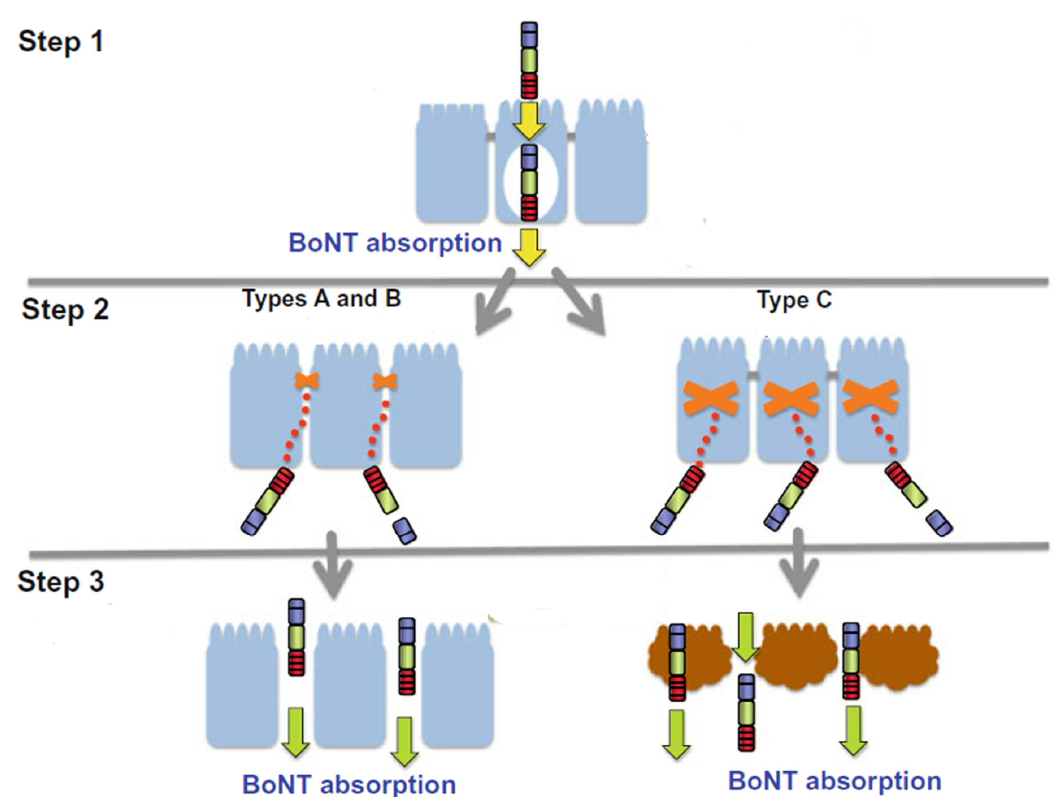
Figure 3. The proposed model for BoNT across the intestinal epithelial barrier (modified from Fujinaga et al., 2012 [77]). Step 1: NAPs/hemagglutinin proteins facilitate the toxin transcytosis through the epithelial cells. Step 2: HA and/or other NAPs mediate the disruption of the epithelial barrier (BoNT/A and /B disrupt the tight junction, while BoNT/C is cytotoxic to the epithelial cells. Step 3: BoNT is absorbed from the disrupted cellular barriers.